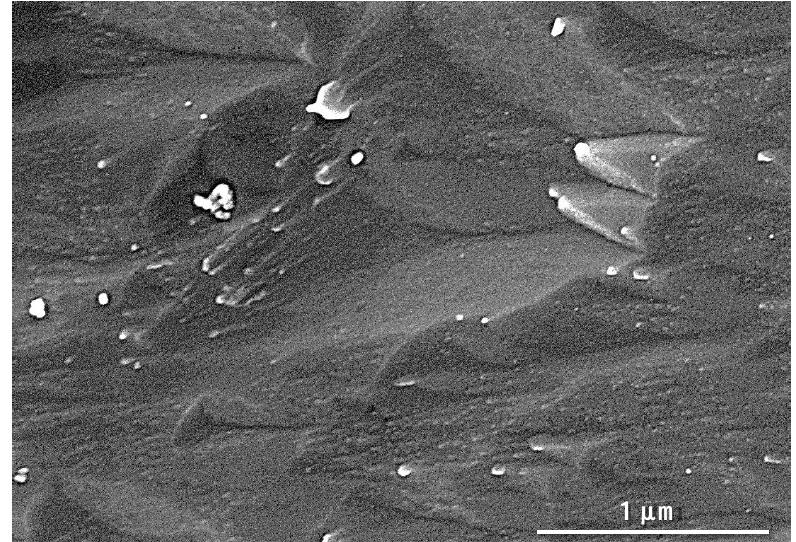
Figure A3. FE-SEM image of microtome-cut, polished, etched and critical-point-dried surface of non-biological aragonite grown from solution.